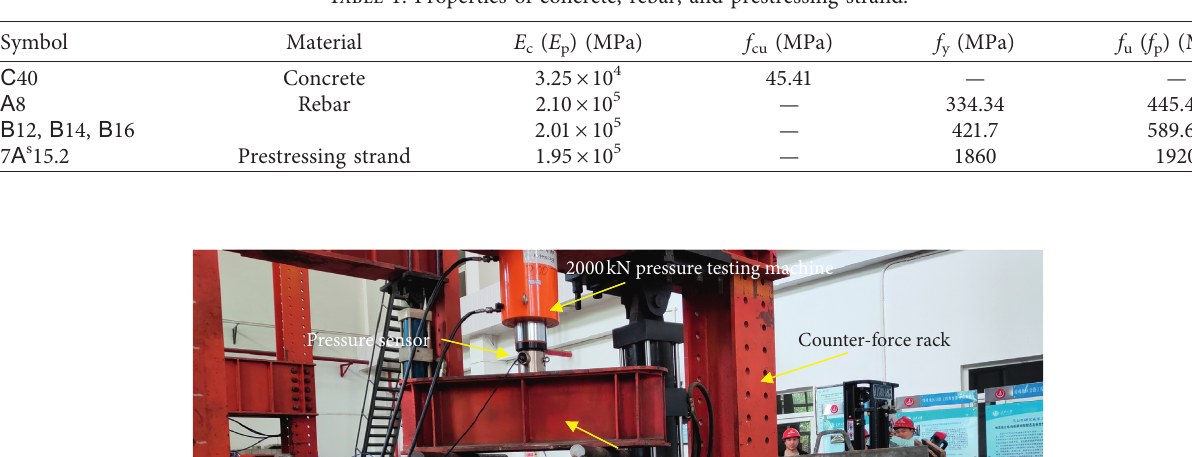
Table 1: Properties of concrete, rebar, and prestressing strand.